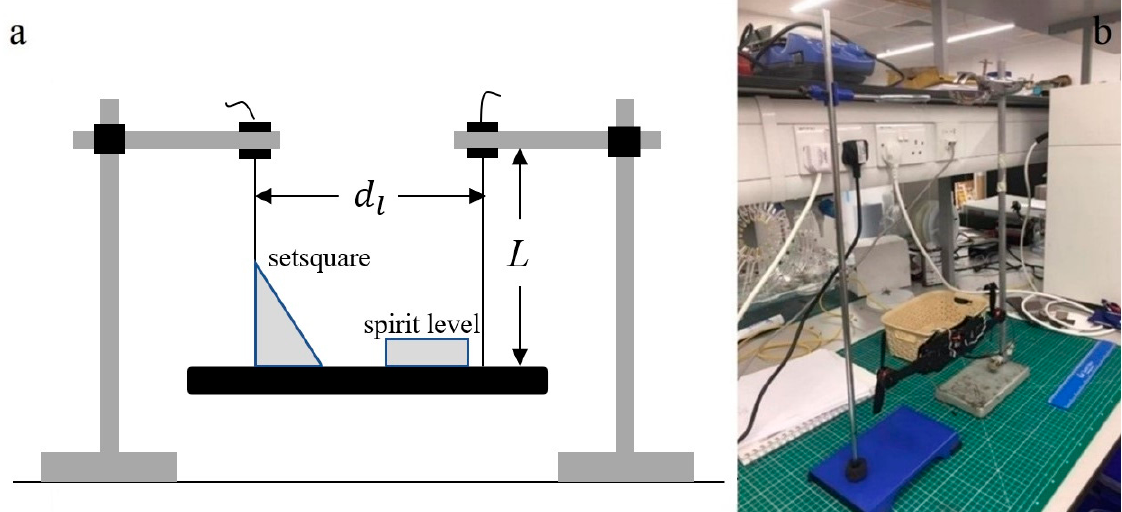
Figure 7. Oscillation of a bifilar Suspension (( a ): Schematic; ( b ): Physical).